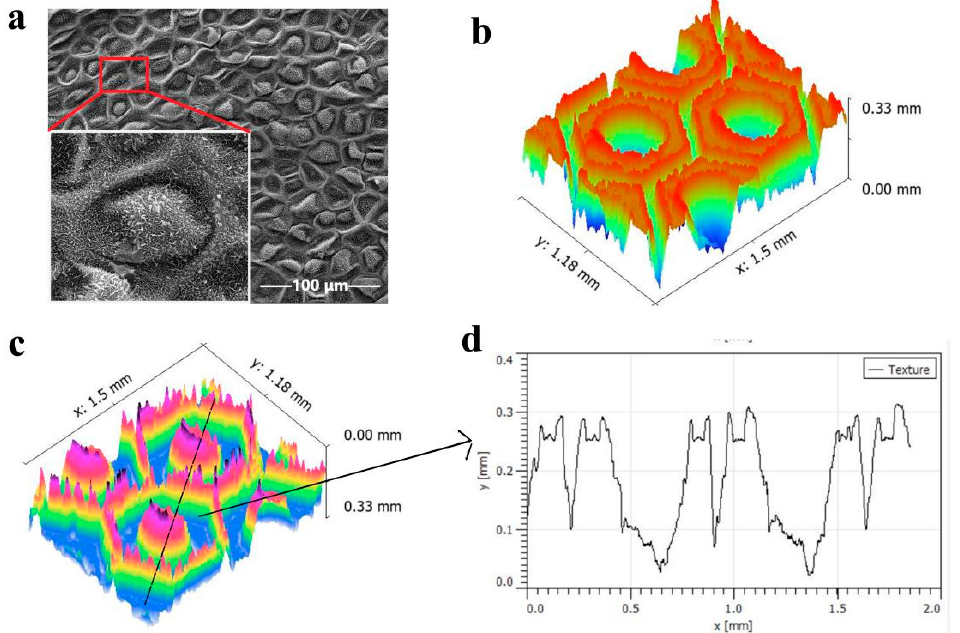
Figure 3. ( a ) The SEM image of a taro leaf surface; ( b ) The 3D morphology of the processed metal template when the laser flux is 71.66 J·cm − 2 ; ( c ) The 3D morphology of the CCP/LIG film obtained by transfer printing of the metal template processed with a laser flux of 71.66 J·cm − 2 ; ( d ) Sectional profile of the CCP/LIG film.